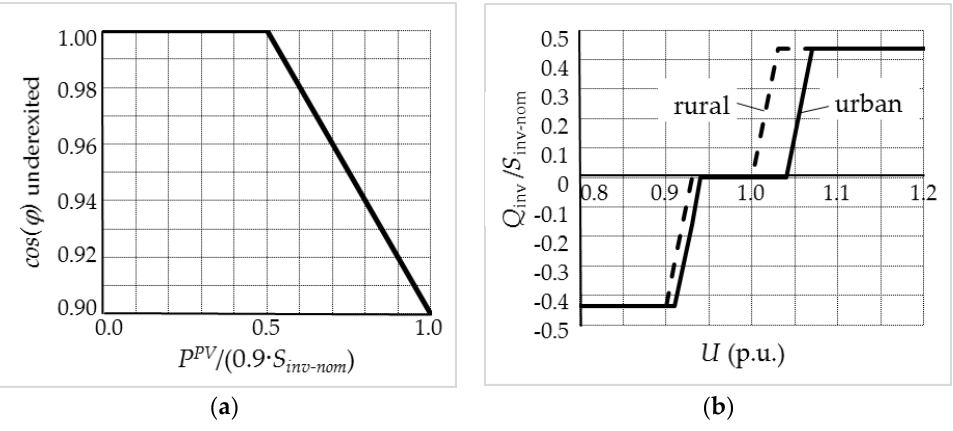
Figure 19. Different inverter control characteristics: ( a ) cos ϕ ( P ) and ( b ) Q ( U